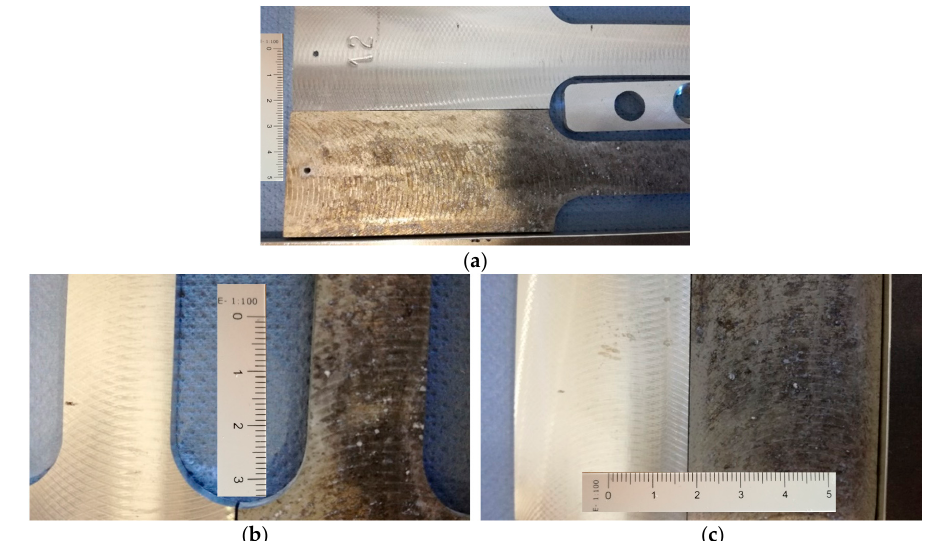
Figure 3. ( a – c ) Subject and no subject to corrosion specimens (scale bar in mm).